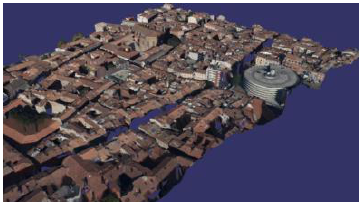
Fig 9. The diagram of 3D schematic after texture mapping